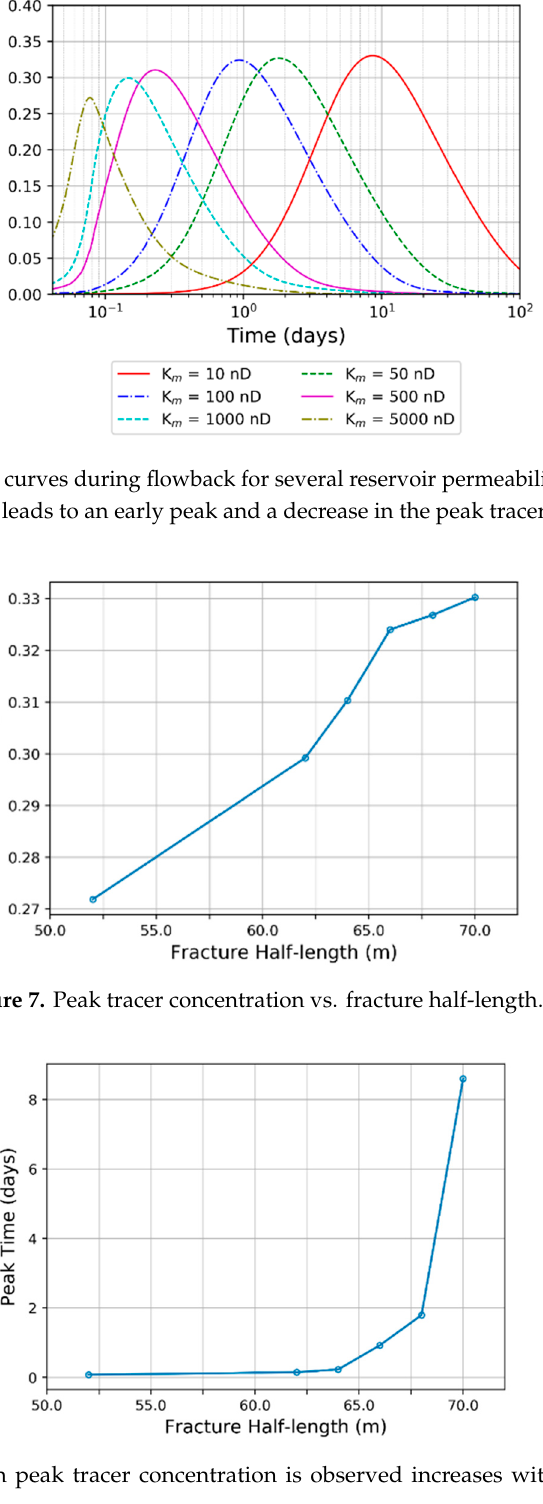
Figure 9. Flowback tracer recovery vs. time when fracture closure is not modeled. 3.2. Impact of Fracture Closure on Tracer Flowback The impact of fracture closure on the tracer response curve and tracer recovery was analyzed. During flowback, increased effective stress on the fracture faces can lead to fracture closure. This fracture closure hinders the tracer transport from the fracture to the wellbore. The fracture closure phenomenon is modeled using the Barton–Bandis normal contact stiffness relationship [28]. The magnitude of fracture closure depends on the fracture stiffness (𝐾 (cid:3041)(cid:3036) ) and offset width. In this section, the fracture stiffness was varied (from 10 8 Pa/m to 10 11 Pa/m) to analyze the impact of fracture closure on the tracer flowback. Reservoir permeability (1 µD) was same for all cases. Figure 10 illustrates the sensitivity of stiffness on the fracture width during the closure. It was observed that the rate of fracture closure is inversely proportional to the stiffness. Figure 11 shows the impact of the fracture closure rate on the tracer response curve. Flowback tracer concentration decreases sharply when fracture stiffness is lower (faster fracture closure). It was also observed that the peak concentration decreases with an increase in fracture closure rate. Figures 12 and 13 demonstrate the impact of fracture closure on the tracer recovered during flowback. These